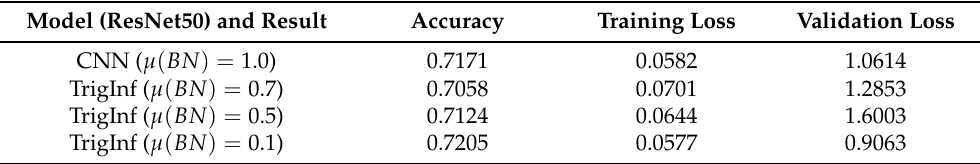
Table 6. Evaluation results on Cifar-100 with BN layers’ mean set to different values. Model (ResNet50) and Result